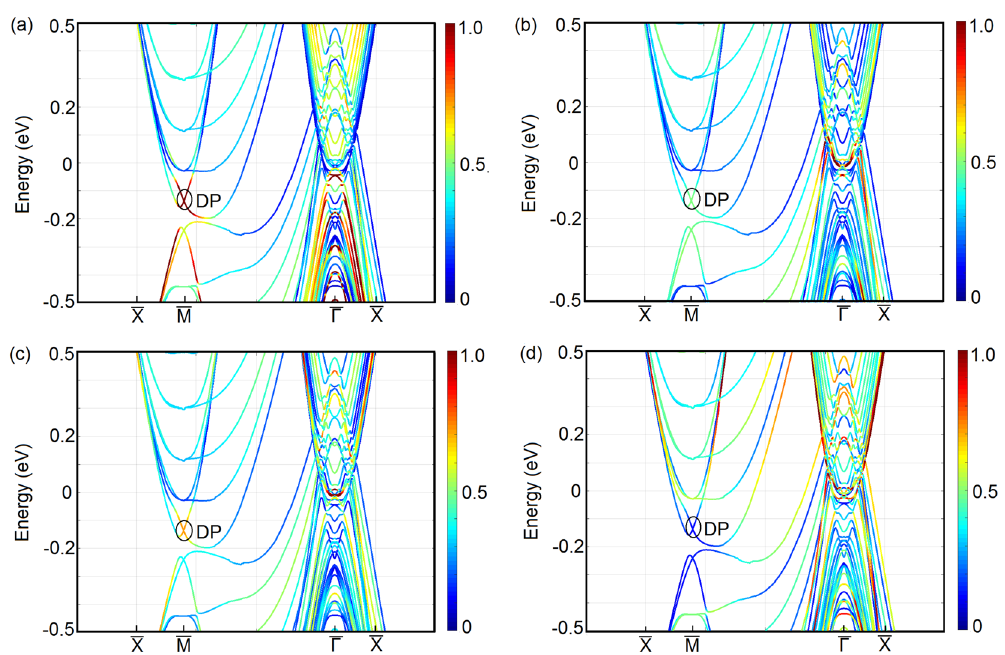
Figure 10. Atomic weights factors of the bands shown in Fig. 9(c) for a 20 layer thick slab. The atomic weights for the ( a ) topmost, ( b ) second topmost, ( c ) third topmost and the ( d ) central bulk layer are given by the line intensity. As seen, the intensity at the Dirac point (DP) is maximum for the topmost (surface) layer i.e. the contribution to the Dirac cone bands at the M point mainly comes from the atoms in the topmost (surface) layer, indicating the surface-state origin of the Dirac cone observed at the (001) surface of the LaSb/LaBi